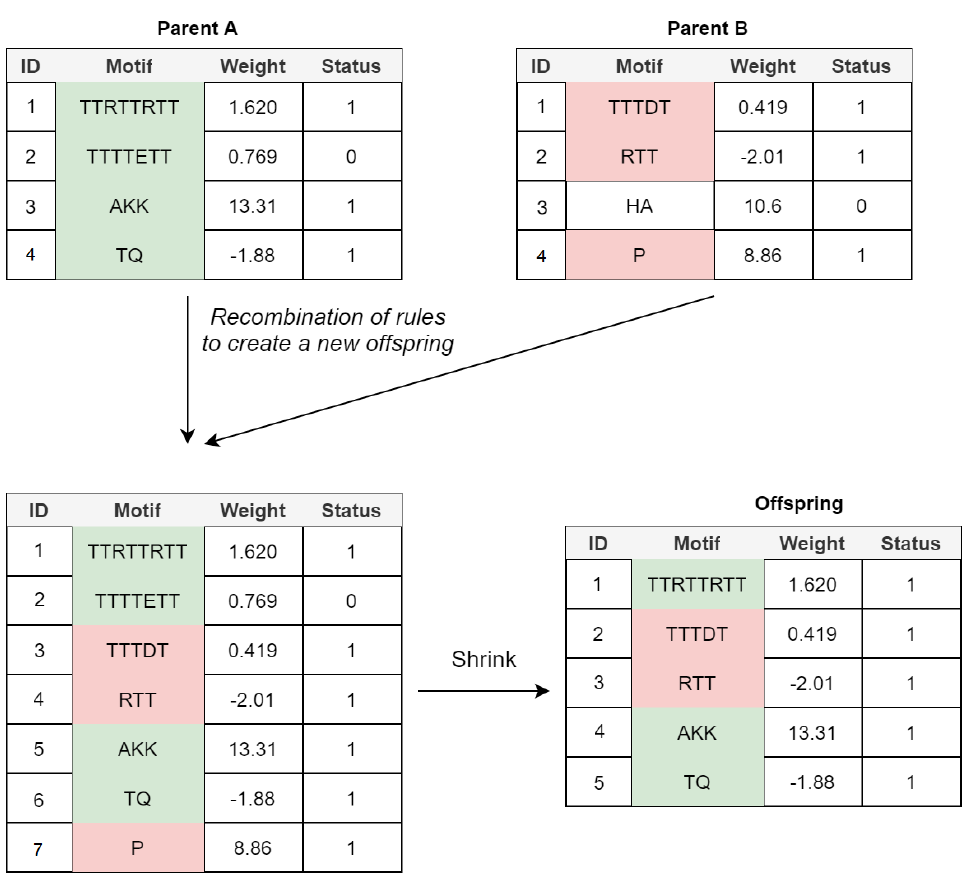
Figure 4 A simple crossover example in POET where the maximum allowed rule count for each model is 5. All the parents’ expressed rules are selected to form the offspring. Unexpressed rules have a 20% chance of being selected while undergoing recombination. In this example, only unexpressed rule 2 of parent A is selected while the unexpressed rule 3 of parent B is not. Recombination of rules forms a new offspring table with size 7. Since the offspring size exceeds the allowed rule count by 2, two rules are removed during the model shrinking process. Unexpressed rules are prioritized to be removed in such a case. Since after removing all the unexpressed rules, the offspring still does not have a legal size, the shortest expressed rule is removed to form the final